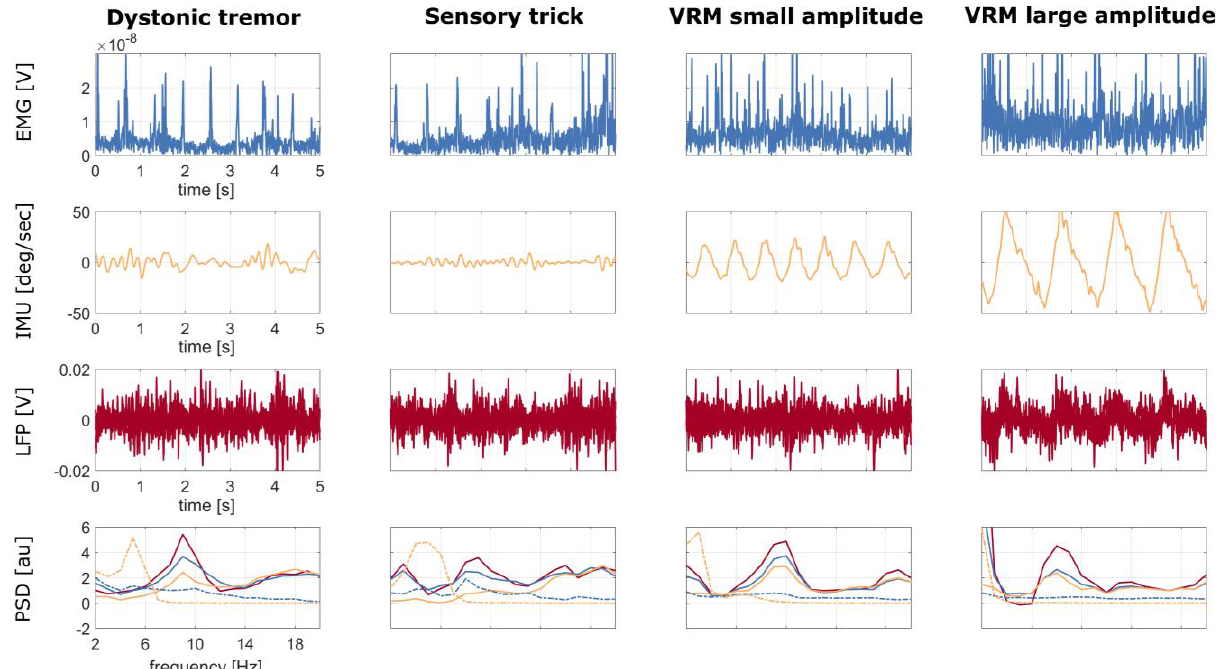
Figure 6. Patient DW02: time series of 5 s recordings at rest (first column), while performing the sensory trick (second column), during voluntary alternating rhythmic movement of the head with small amplitude (third column), and with large amplitude (fourth column), of the right sternocleido- mastoid EMG (first row), IMU (second row), and LFP (third row) without regression. IMU and LFP time series were averaged over channels, i.e., over the three axes (x, y, z) and over the six contact pairs (0 – 3, 0 – 2, 1 – 3 left and right), respectively. The corresponding PSDs are shown in the fourth row: LFP without regression (continuous red line), LFP with EMG regression (continuous blue line), LFP with IMU regression (continuous yellow line), EMG (dotted blue line), and IMU (dotted yellow line). Abbreviations: VRM — voluntary rhythmic movement.